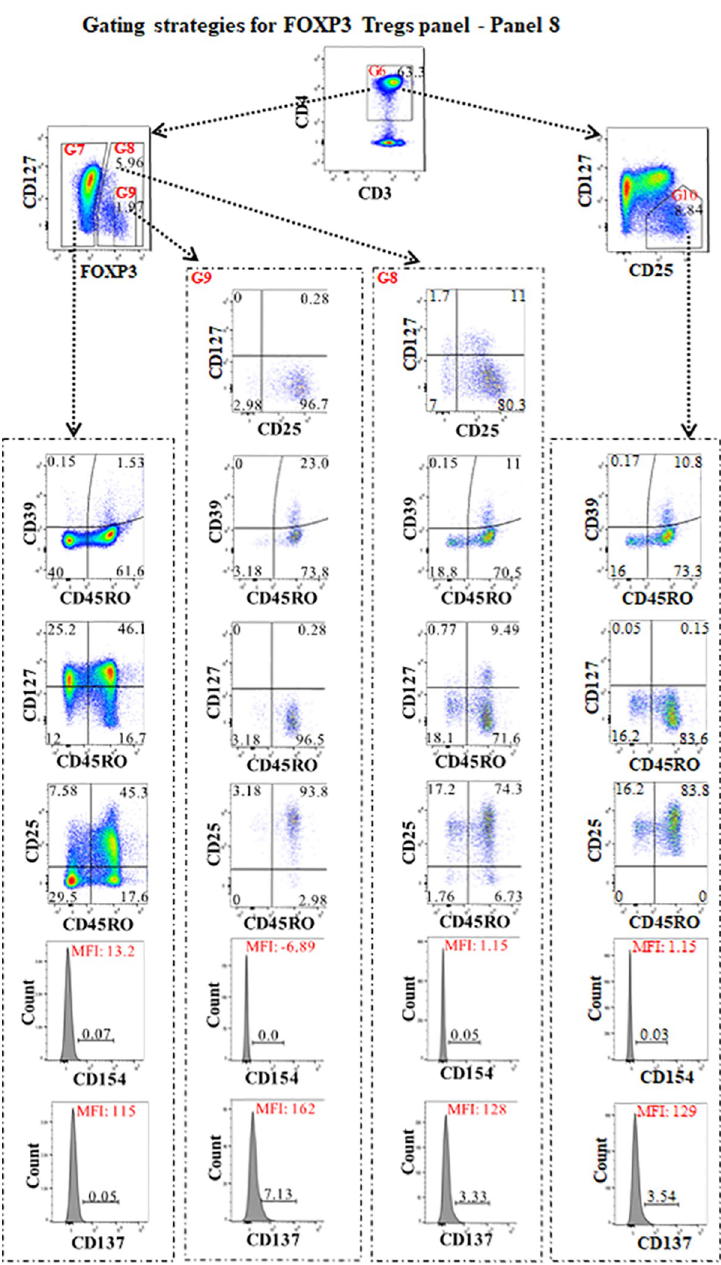
Fig 6. The gating strategies for identifying FOXP3+ Tregs (panel 8). For panel 8, the strategies of the first to fifth gates were the same as in panels 5 and 6 (Figs 4B and 5A). After gating on CD3+CD4+ T cells (G6), FOXP3 vs CD127 was used to assess the proportions of CD4+FOXP3- effector cells (G7), CD4+FOXP3+Tregs (G8) and CD4+FOXP3 +bright (G9) Tregs. CD25 vs CD127 were used to assess CD25+CD127-/dim Tregs. After gating on CD4+FOXP3- effector cells (G7), CD4+FOXP3+ Tregs (G8), CD4+FOXP3+bright Tregs (G9), and CD25+CD127-/dim (G10), CD45RO vs CD39, CD45RO vs CD127, and CD45RO vs CD25 were used for assessment of CD39, CD127 and CD25 expression on memory (CD45RO+) or na ï ve (CD45RO-) non-FOXP3 effector T cells, and CD4+FOXP3+, CD4 +FOXP3+bright, or CD25+CD127-/dim Tregs. Gating on FOXP3+ (G8) and FOXP3+bright (G9) Tregs, and gating on CD25 and CD127 identified CD25+CD127-/dim, CD25+CD127+, CD25-CD127- and CD25-CD127+ on Foxp3 +/brightTregs. The histogram of CD137 and CD154 was assessed on these cell types.